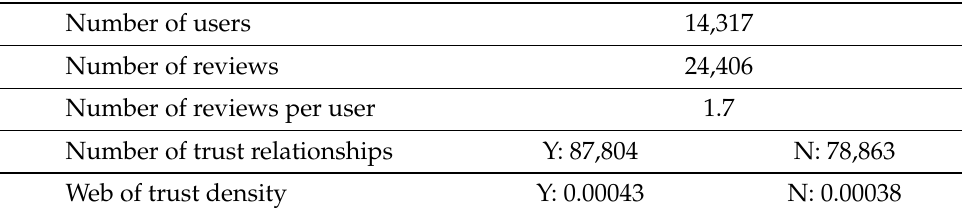
Table 7. Dataset